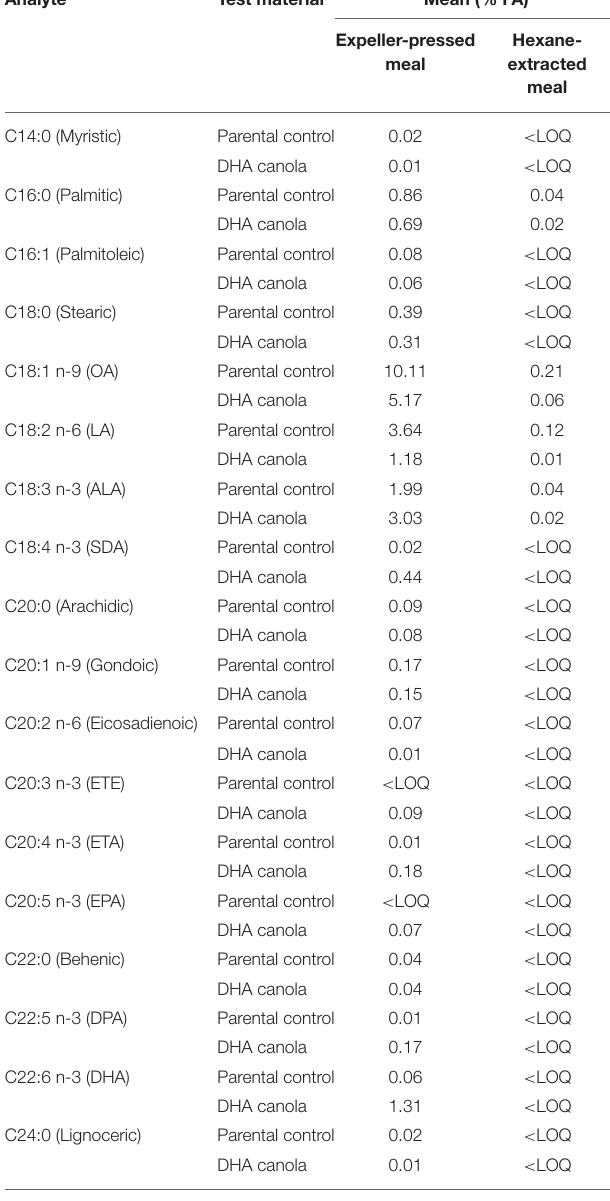
TABLE 4 | FA of expeller-pressed and hexane-extracted DHA canola meal (% of total FA).